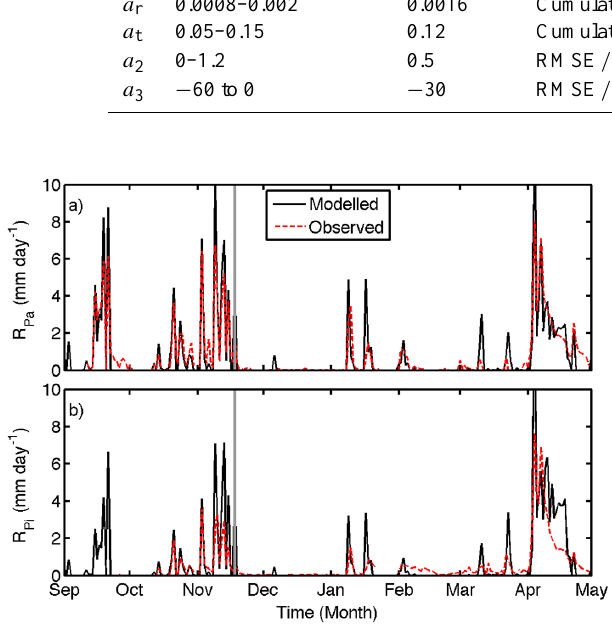
Figure 5. Modelled and observed runoff at (a) Pa and (b) Pi (in- dependent) sites. The grey line indicates when the snow starts to accumulate on ground; the snowmelts by the end of